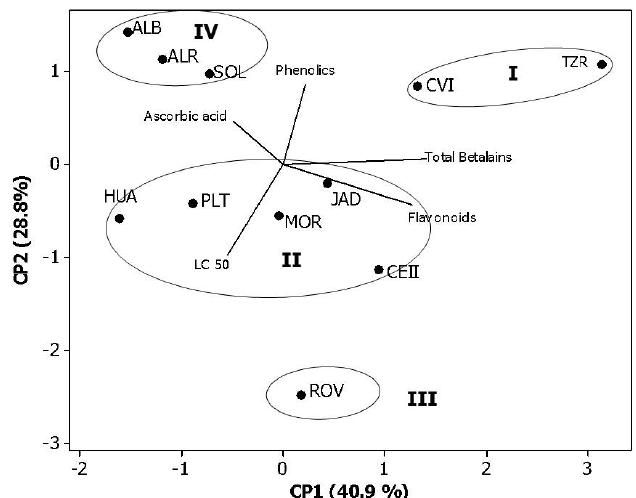
Fig. 2: Scatterplot of the principal component analysis of the pulp of 11 varieties of prickly pear by antioxidant metabolite type. Alteña Blanca (ALB), Alteña Roja (ALR), Copena CEII (CEII), Copena VI (CVI), Huatusco (HUA), Jade (JAD), Tzaponopal Rojo (TZR), Morada (MOR), Plátano (PLT), Roja Villanueva (ROV), and Sol- ferino